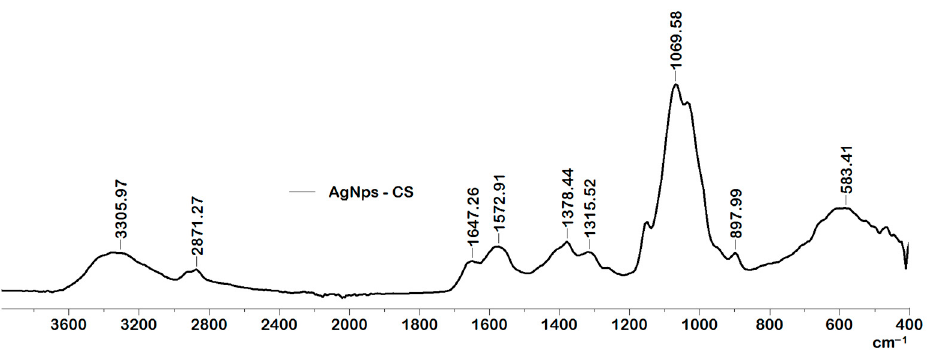
Figure 1. FT-IR spectra for AgNps covered with CS.